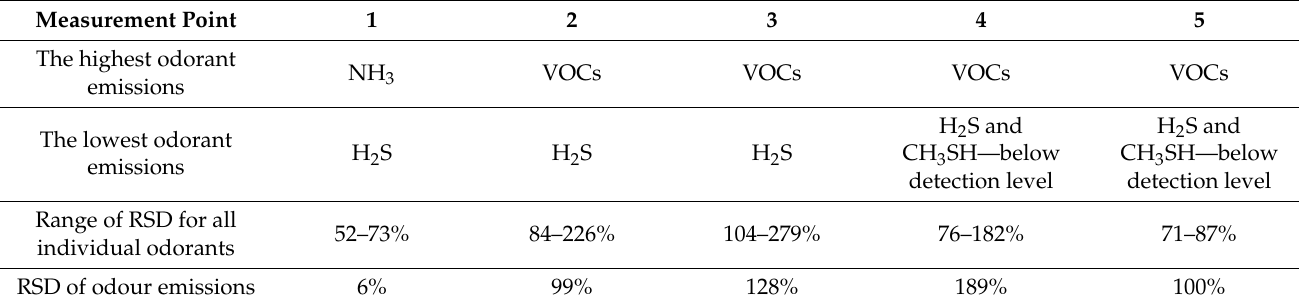
Table 6. Odour load characteristics from individual measuring